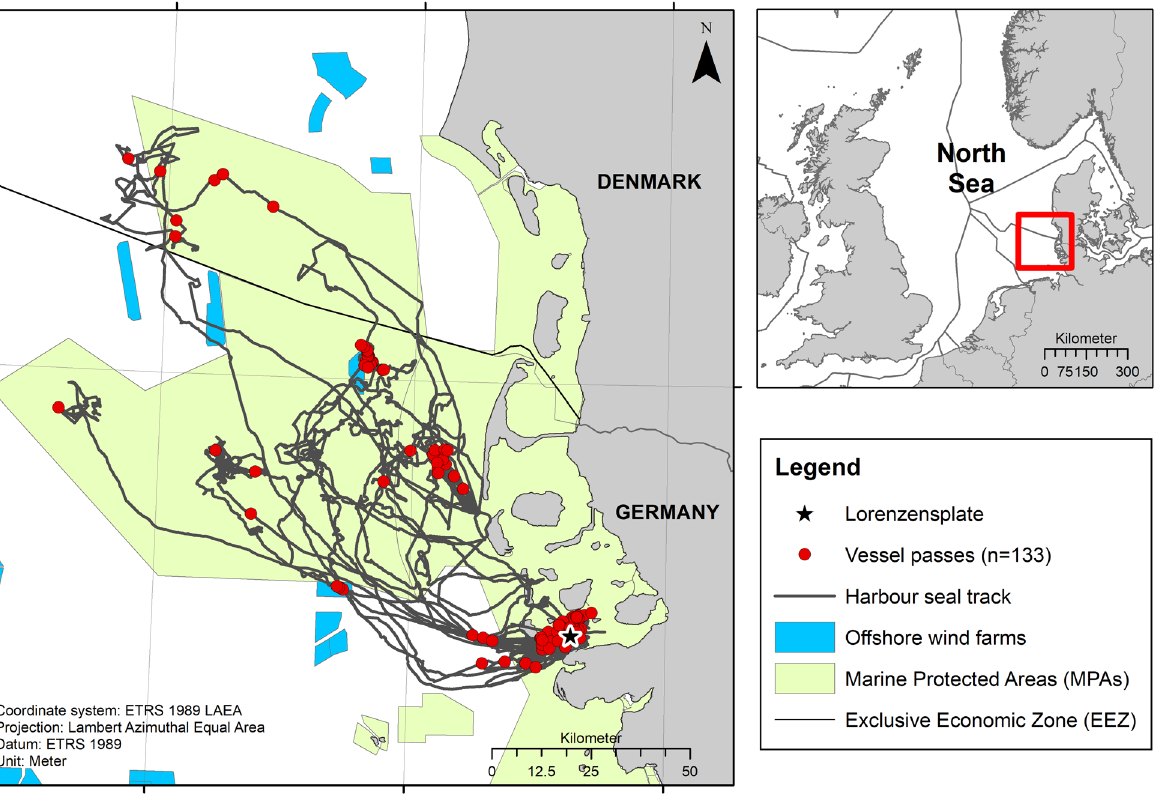
Figure 2. Tracks of harbour seals (n = 9) in the North Sea. The red dots illustrate the locations of high level vessel passes during on-effort periods (n = 133). The tagging site Lorenzensplate is indicated by a black star. Harbour seals were tagged in three catches over two consecutive years. The map was created using ESRI ArcGIS, version